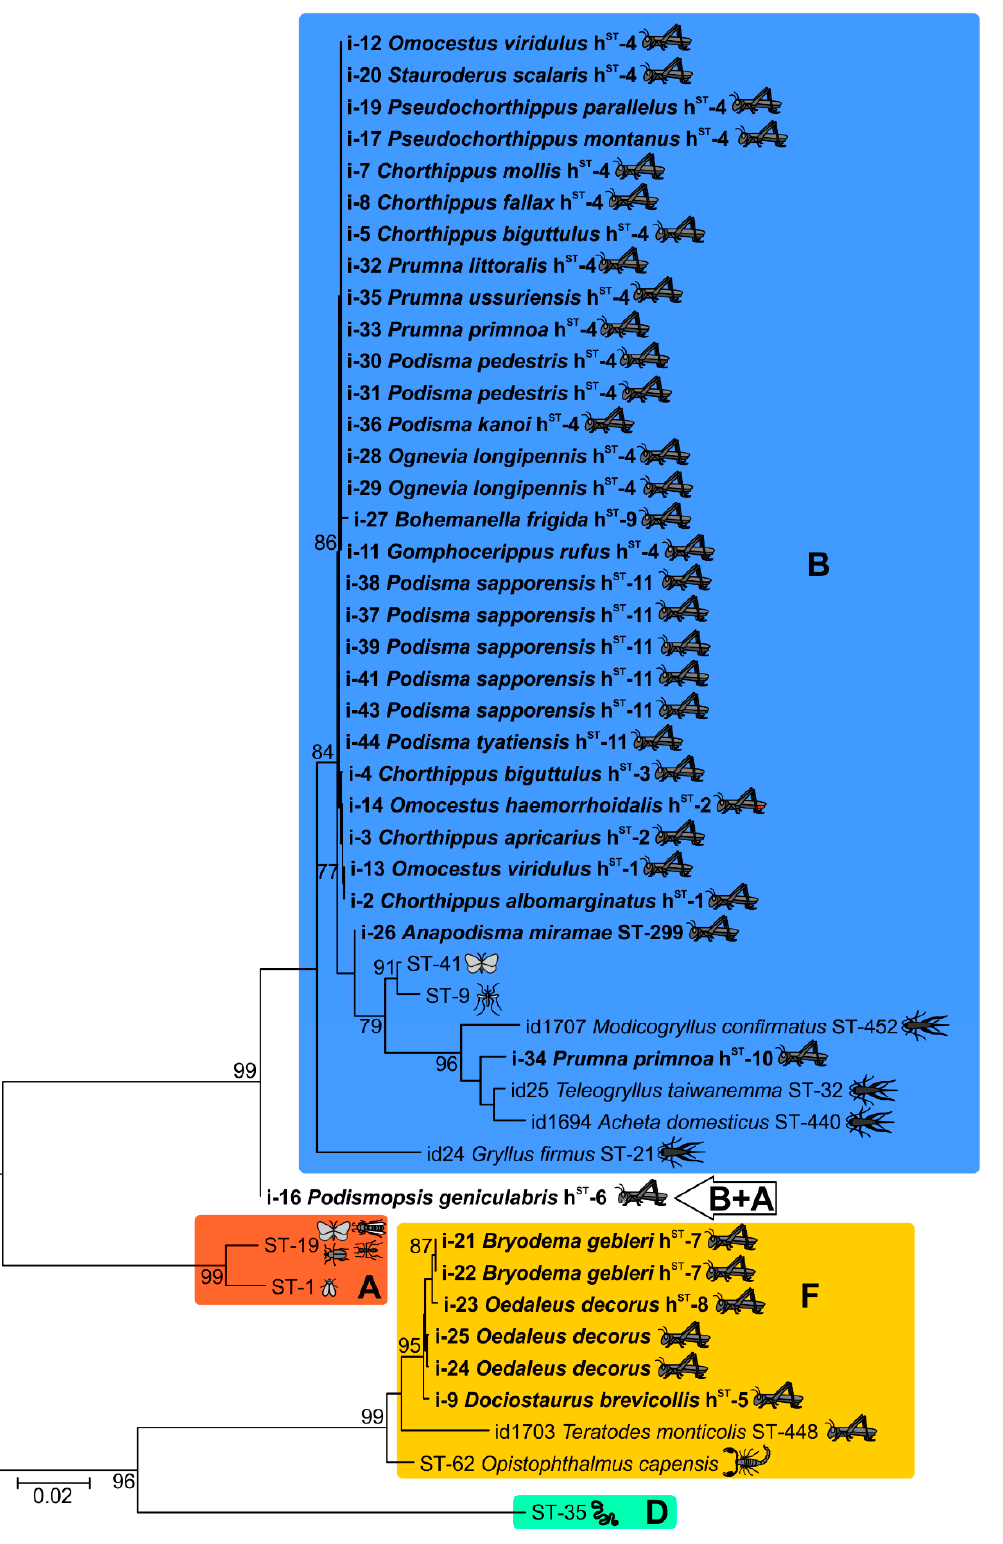
Figure 2. An ML phylogenetic tree of Wolbachia symbionts isolated from Acrididae hosts. The dataset is based on the concatenation of five genes of the MLST protocol, model T92+G, and bootstrapping with 1000 iterations (values higher than 75 are provided). See original files in Supplementary Materials.